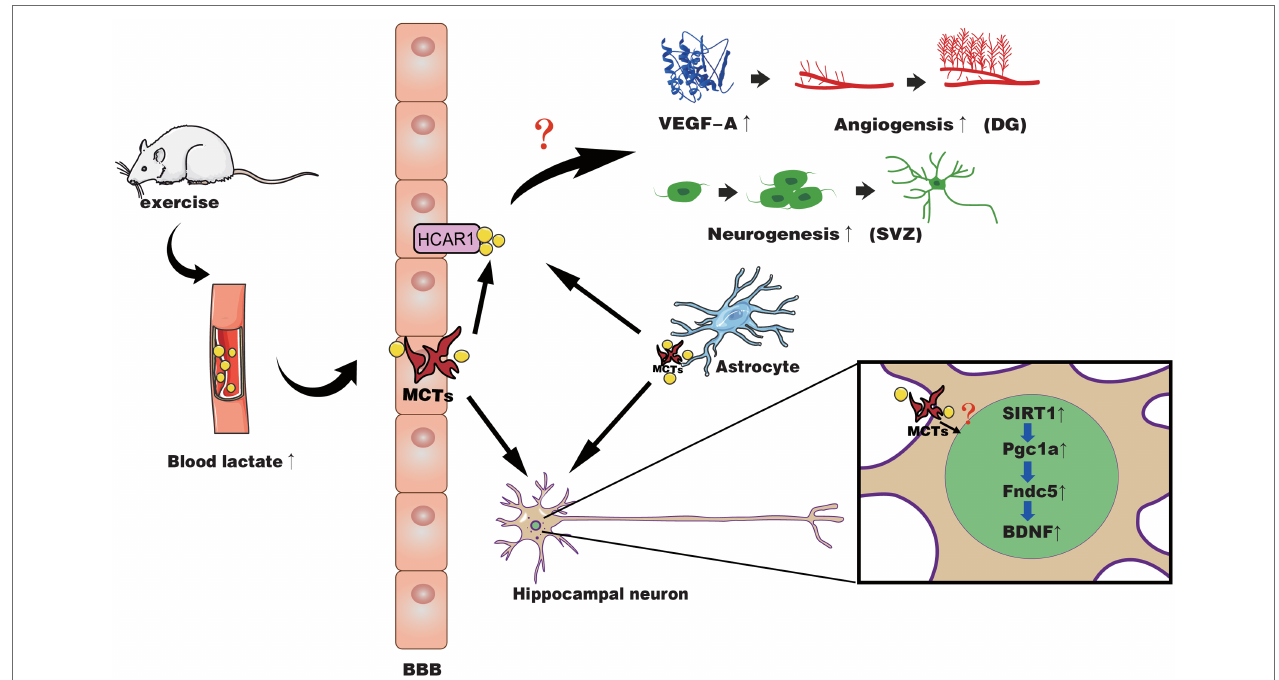
FIGURE 1 | The possible mechanisms of lactate in exercise-induced positive effects on neuroplasticity and cerebrovascular plasticity. Exercise causes muscles to produce lactate, which is then released into the blood and passes through the BBB through different MCTs into the brain parenchyma. Meanwhile, astrocytes may also release lactate during exercise to supply the neural network in response to activated neurons. At the BBB of the microvasculature, lactate binds to HCAR1 to activate it and induces increased VEGF-A expression in the hippocampal dentate gyrus (DG), angiogenesis, and neurogenesis of SVZ through an unidentified pathway. In hippocampal neurons, lactate is transported across the membrane by MCT, activating the SIRT1/PGC1- α /FNDC5/BDNF pathway through an unknown pathway, thereby improving neural